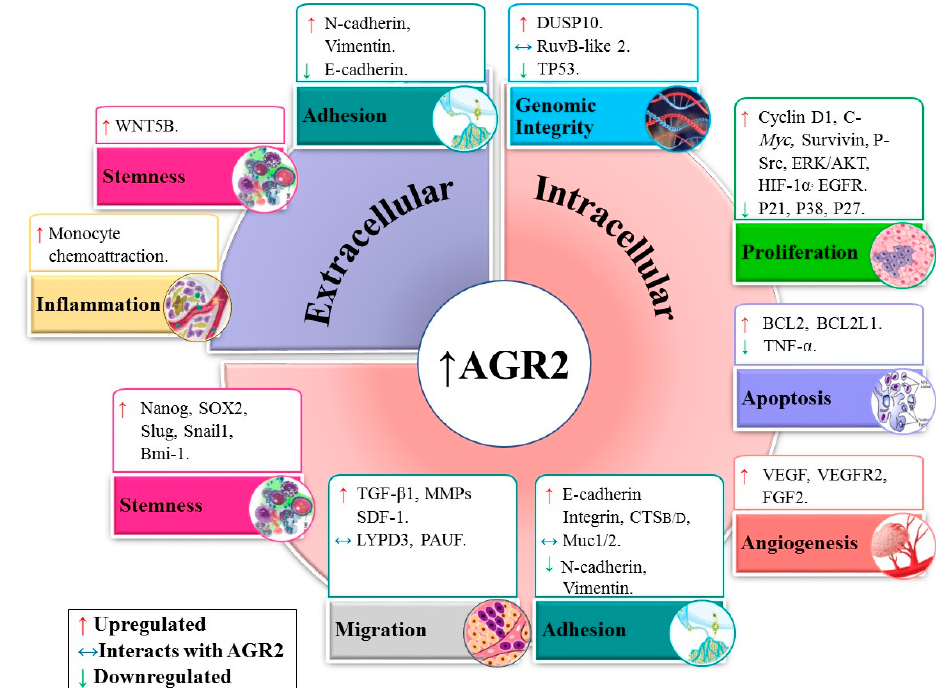
Figure 3. The overexpression of intracellular AGR2 and the presence of extracellular AGR2